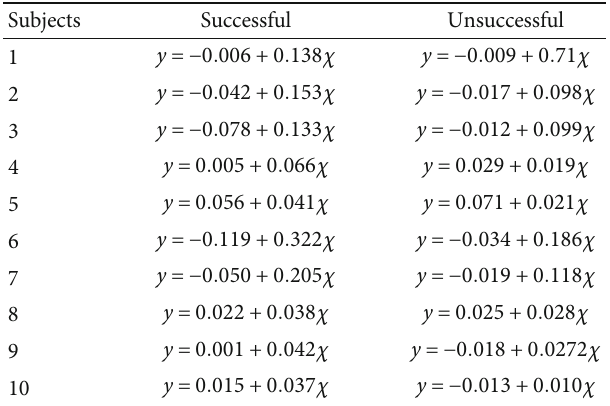
Table 7: Linear regression equation of variation trend of the human and bar combination barycenter on the X - axis.